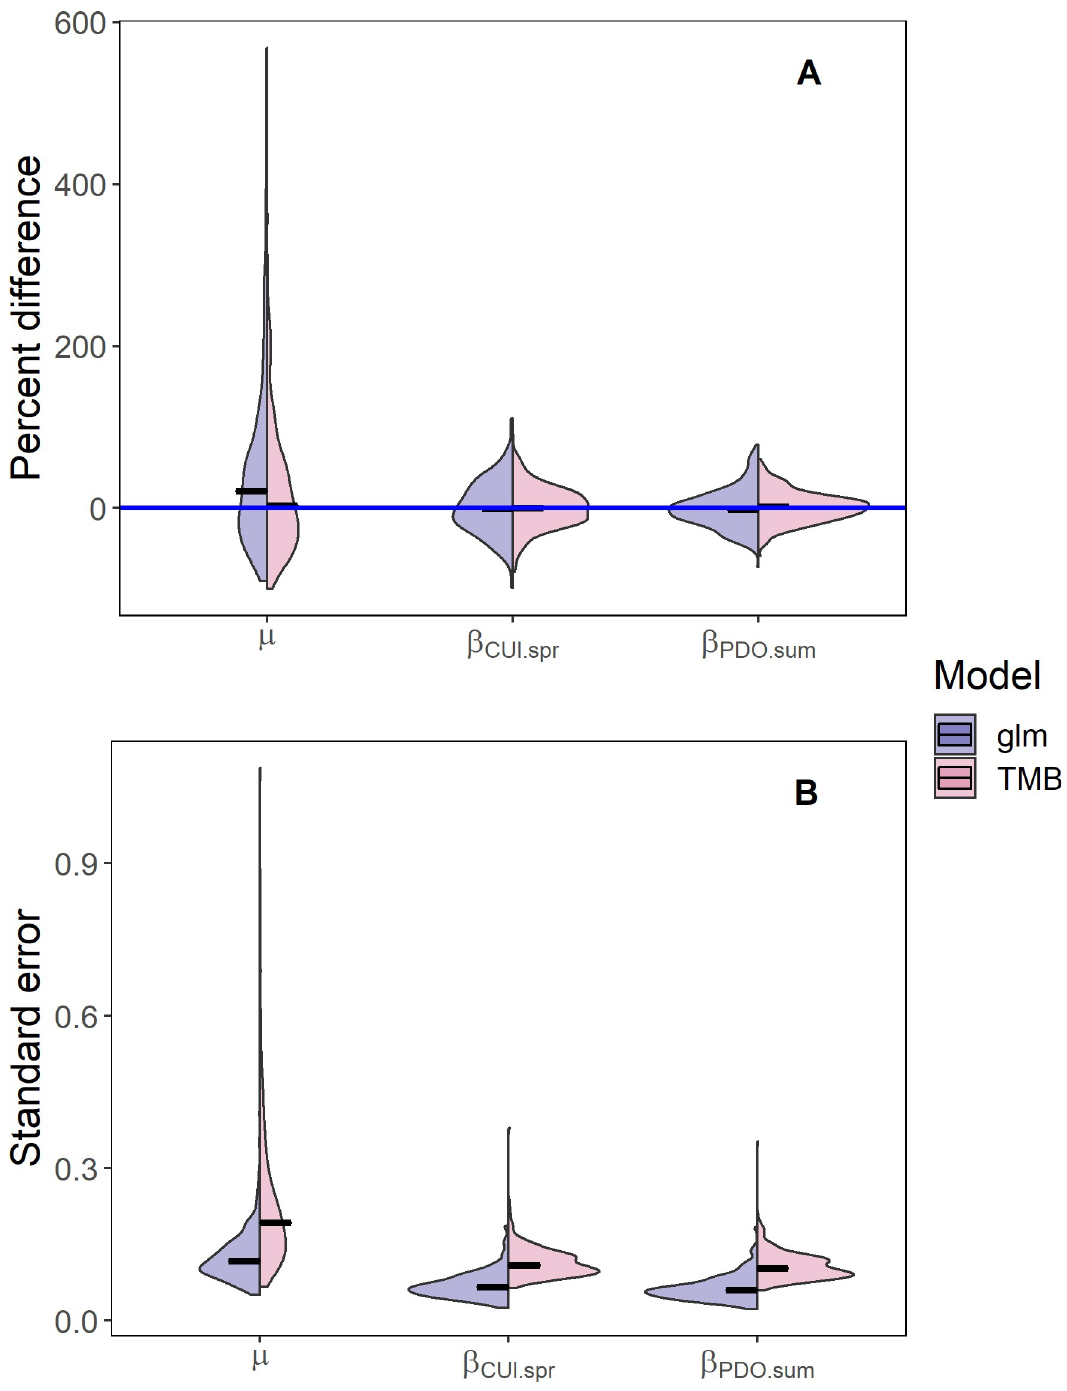
Fig 6. Differences between the mean survival and standard error of the mean survival for models with fixed and random effects. Split violin plot comparing the percent difference (upper panel) between the estimated and true parameter values and the standard errors for the fixed effects μ , β , and β (lower panel) for the mixed-effect model with AR1 processes for day and CUI . spr PDO . sum day/year interaction (TMB; blue violins) and the fixed-effect model for day, day2, and day/year interaction (glm; red violins) fit to simulated data for wild spring/summer Chinook salmon. Simulated the data were generated from the model with the lowest AIC for wild fish (see Table 4). Horizontal lines represent median values for the violins and the horizontal blue line in panel (A) represents zero percent difference between the estimated and true parameter